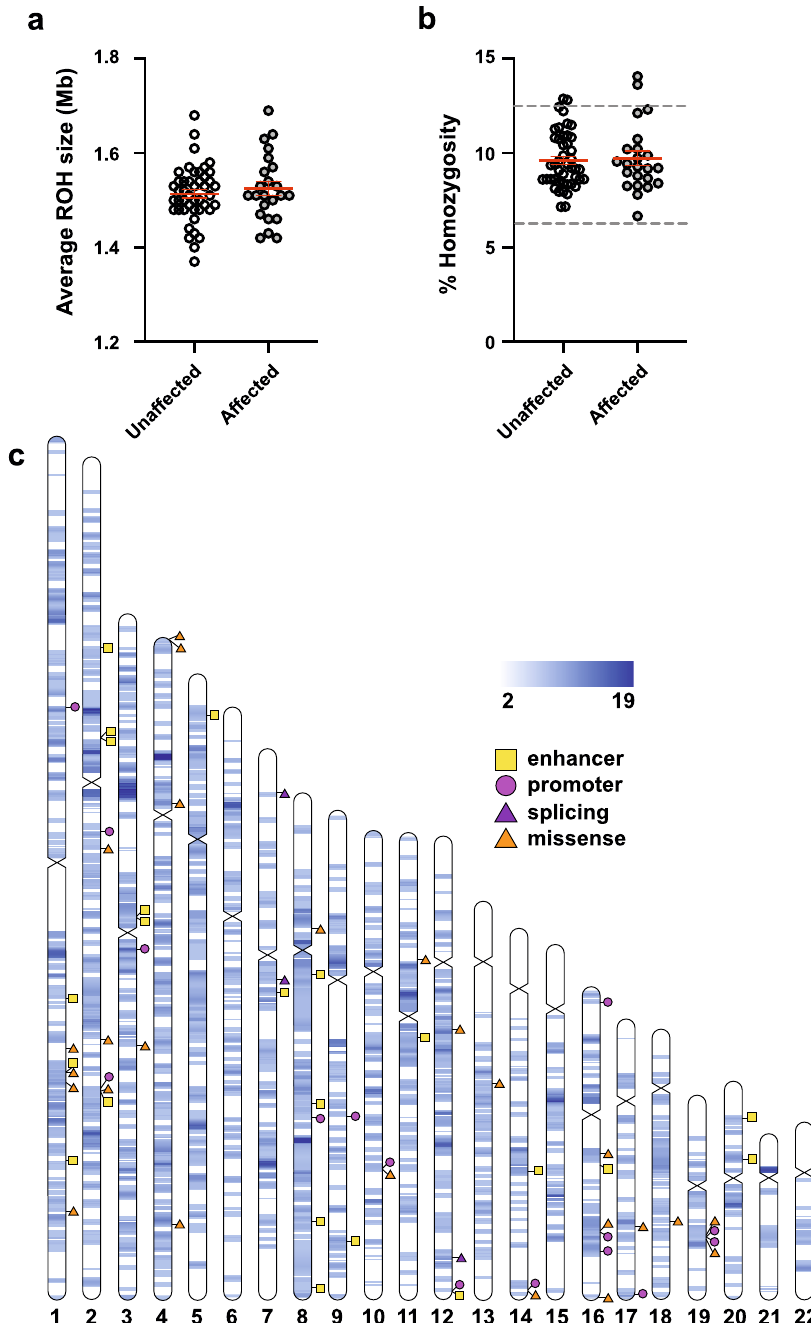
Fig. 1 Runs of homozygosity in the consanguineous ASD cohort. There were no signi fi cant differences in average size of ROHs ( a ) or total percent of homozygosity across the genome ( b ) between affected and unaffected individuals (mean ± SEM are shown in red). In b dotted lines denote the expected % homozygosity for children of second- and third-degree relatives (12.5% and 6.25%, respectively). Data were analyzed using unpaired t test ( N = 23 affected, 45 unaffected; P = 0.4599 ( a ), P = 0.7878 ( b )). c ROHs shared between unrelated probands, with rare inherited homozygous nonsynonymous variants and brain-speci fi c regulatory element variants that map within them. The color scale indicates the number of probands sharing an